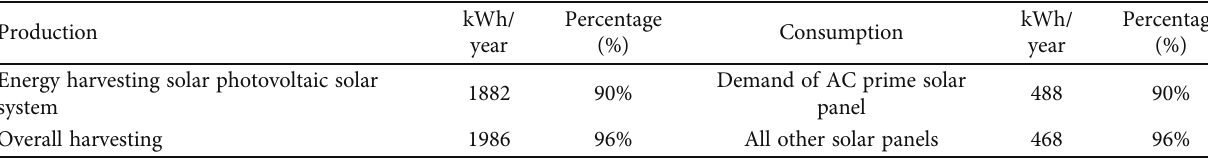
Table 1: Annual solar power fabrication and utilization.